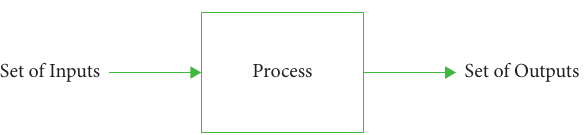
Figure 1: Genetic programming simplified activity flow for inputs, process, and outputs.